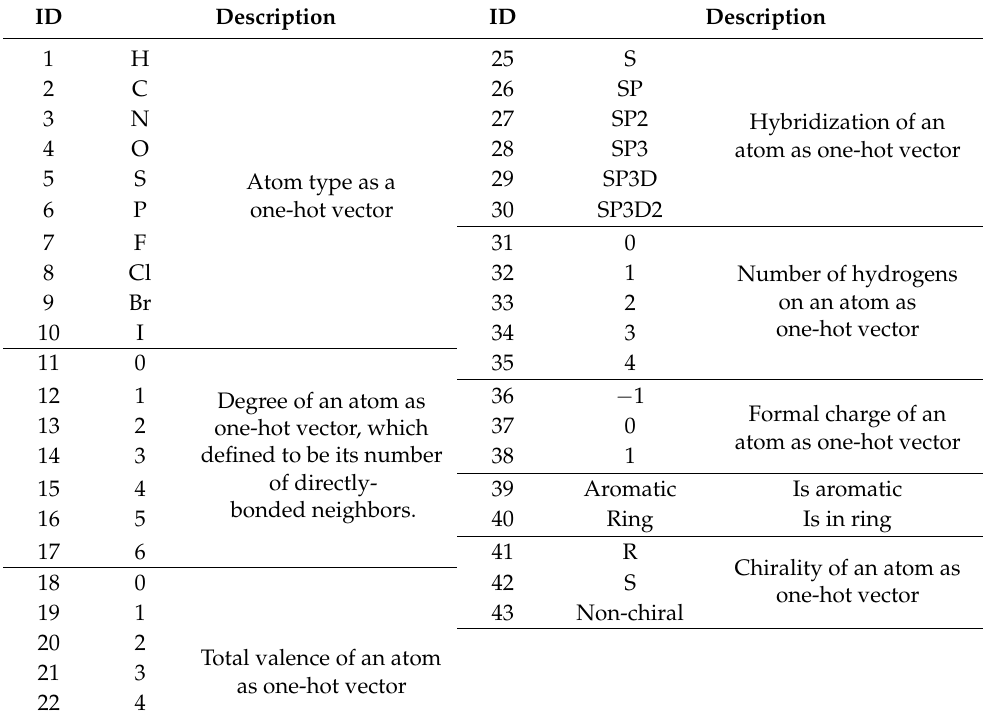
Figure 1. Generation of atomic features set. ( a ) Pseudocode of atomic features set. ( b ) A visual representation of the set of initial atomic features. ( c ) The construction of atomic features at radius R. Table 1. Forty-three atomic features.